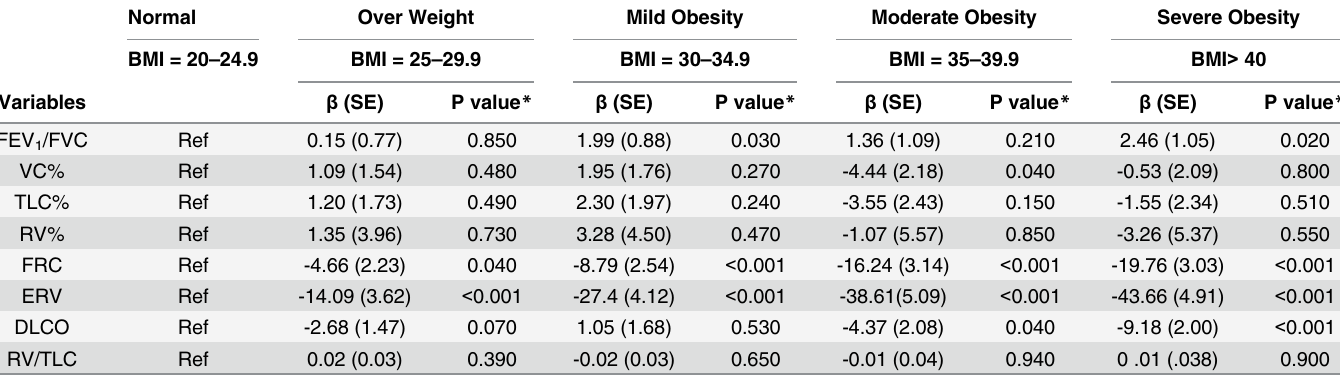
Model : Lung Function = BMI + Age + Gender